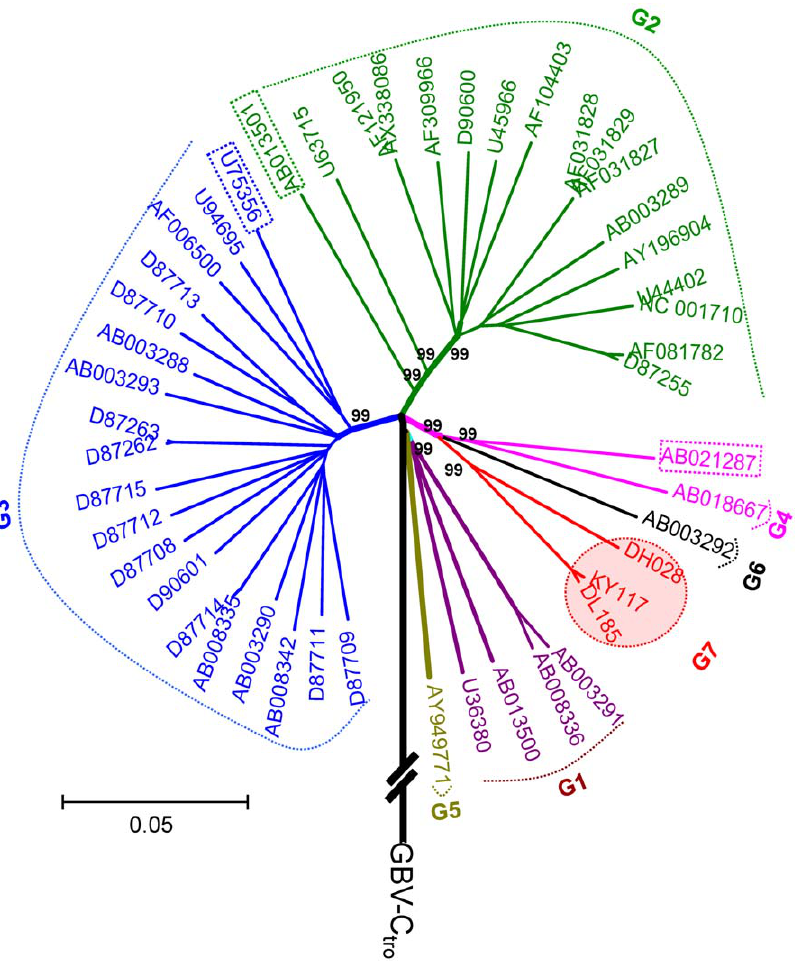
Figure 4. Rooted phylogenetic tree based on the full-length GBV-C genome sequences of 48 isolates. The isolate GBV-C tro (Genbank accession no. AF070476) was used as an outgroup. The symbol//indicates a trimmed branch. Putative recombinant isolates are boxed with dashed lines. Otherwise all the labels are as the same as shown in figure 2.